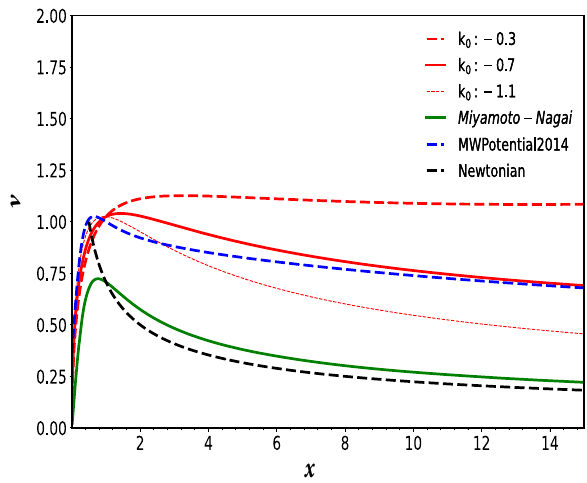
Fig. 1 Milky-way idealised rotation curves comparison between the effective velocity with the additional nearly-Newtonian contribution (referred to colour in electric version as the dashed, thick and dotted red lines in the curves). The Miyamoto-Nagai and MWpotential2014 potentials are indicated by the thick green and dashed-thick blue lines. The Newtonian curve is indicated by the dashed black line. We use galpy units normalised as the velocity v = 1 at x =